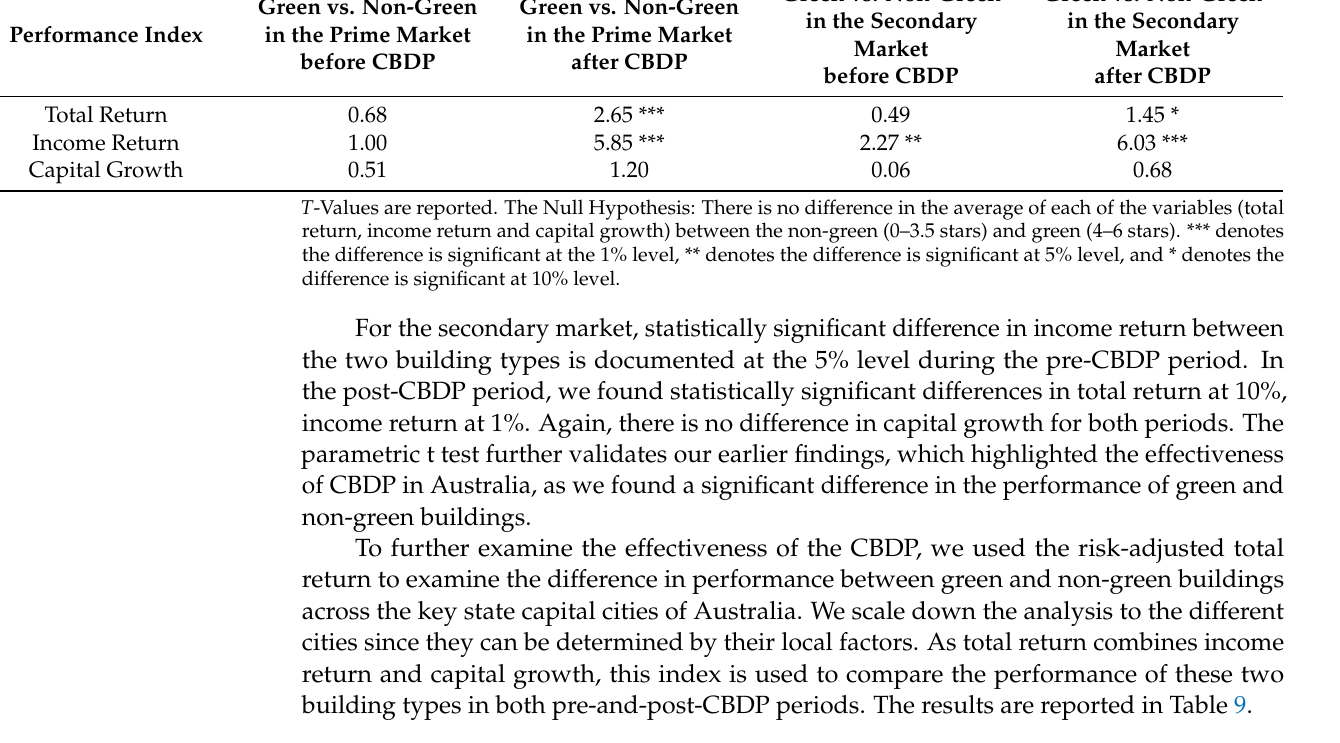
Table 9. Total return of non-green vs. green in key cities of